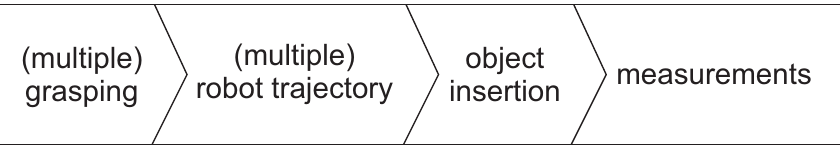
Figure 1. The primary division of robot grasping, manipulation, and